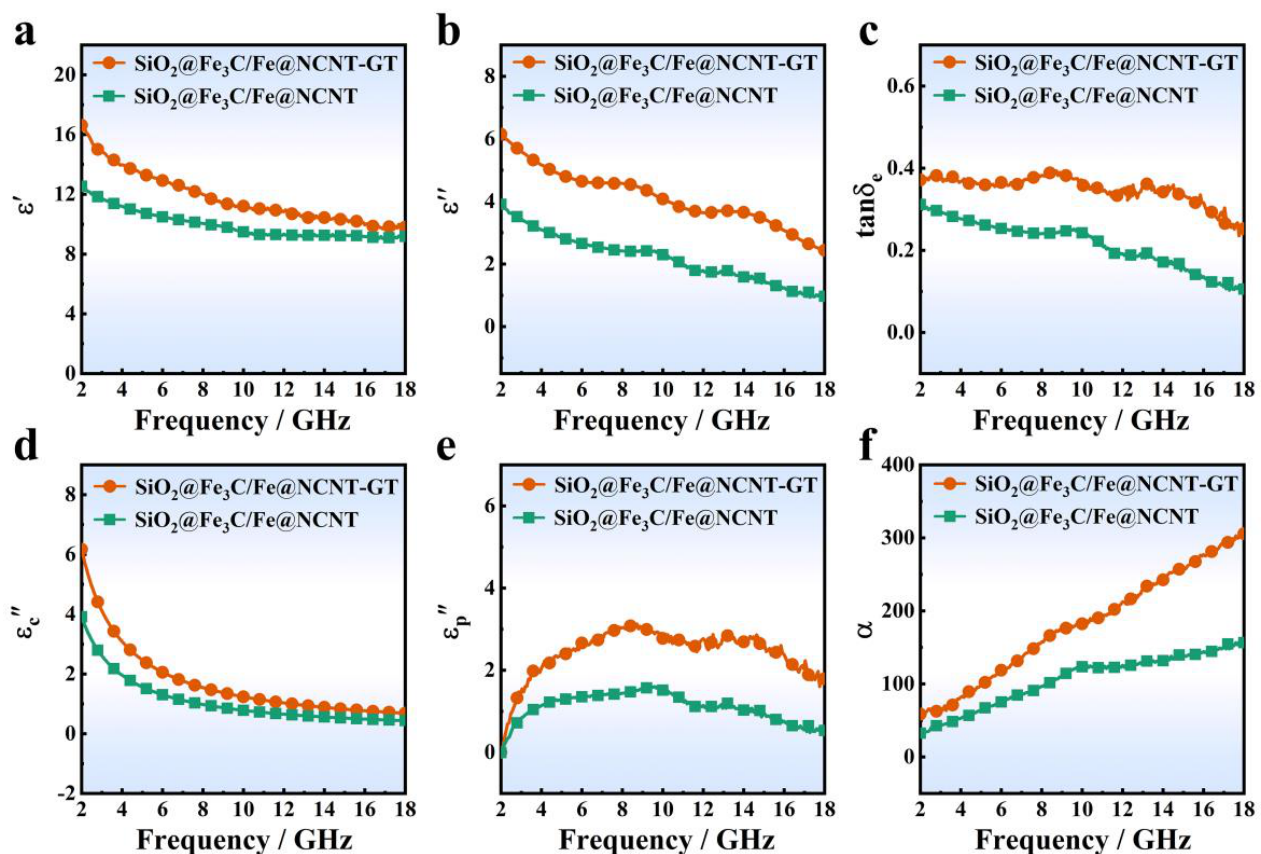
Figure 4. ( a ) ε (cid:48) — f curves, ( b ) ε ” — f curves, ( c ) tan δ e — f curves, ( d ) ε c ” — f curves, ( e ) ε p ” — f curves and ( f ) α — f curves of Figure 4. ( a ) ε ′— f curves, ( b ) ε″ — f curves, ( c ) tan δ e — f curves, ( d ) ε c ″ — f curves, ( e ) ε p ″ — f curves and ( f ) α— f curves of SiO 2 @Fe 3 C/Fe@NCNT-GT and SiO 2 @Fe 3 SiO 2 @Fe 3 C/Fe@NCNT-GT and SiO 2 @Fe 3 C/Fe@NCNT.